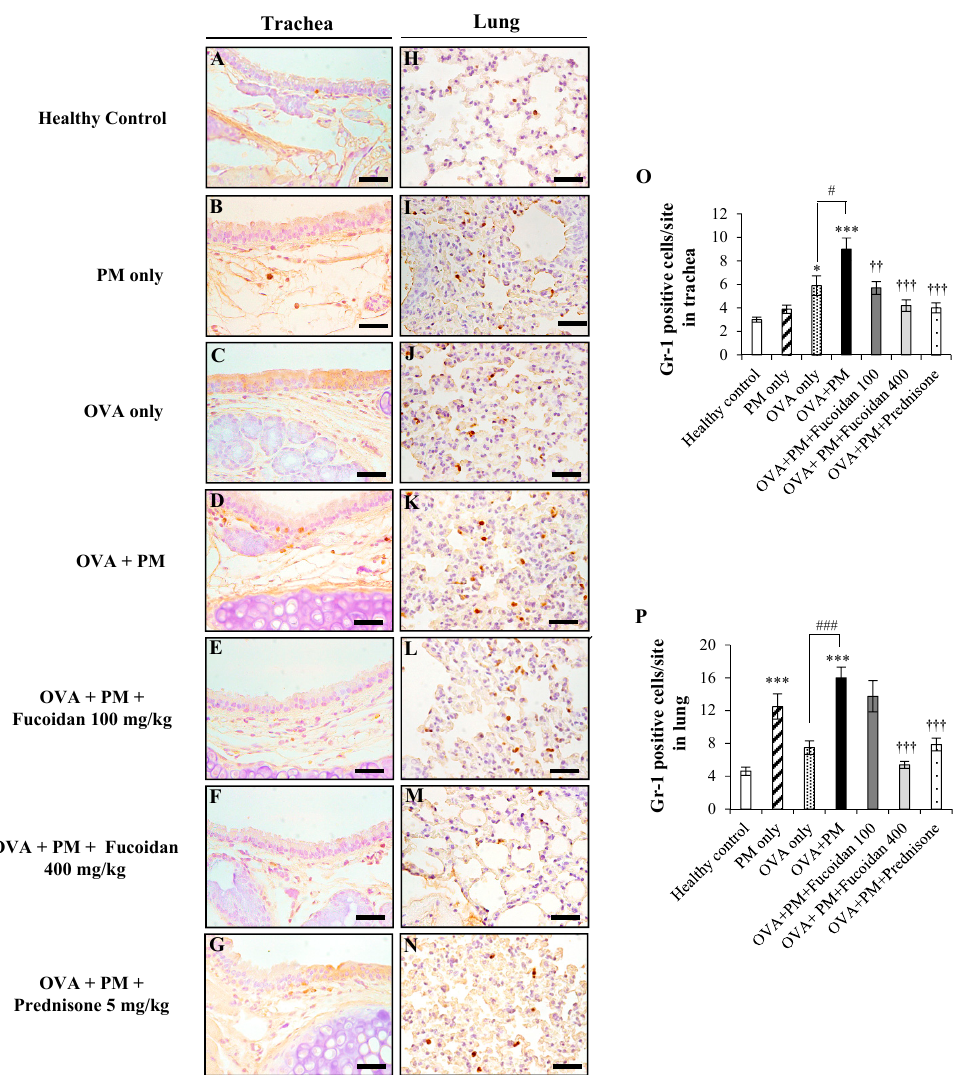
Figure 5. Immunohistochemical analysis of Gr-1 + cells in the trachea ( A – G ) and lungs ( H – N ). ( A , H ) Healthy control, ( B , I ) PM only, ( C , J ) OVA only, ( D , K ) OVA + PM, ( E , L ) OVA + PM + Fucoidan (100 mg / Kg), ( F , M ) OVA + PM + Fucoidan (400 mg / Kg), ( G , N ) OVA + PM + Prednisone (5 mg / Kg). ( O ) Gr-1 + cells per site in the trachea, ( P ) Gr-1 + cells per site in the lungs. Values are expressed as means ± SEM ( n = 3). * ( p < 0.05), *** ( p < 0.0005) represent significant increases compared with the healthy control, and †† ( p < 0.005), ††† ( p < 0.0005) denote significant decreases compared with the OVA + PM group. # ( p < 0.05), ### ( p < 0.0005) denote significant increases ( p < 0.05) compared with the OVA only group. The scale bar of ( A – N ) is 25 µ